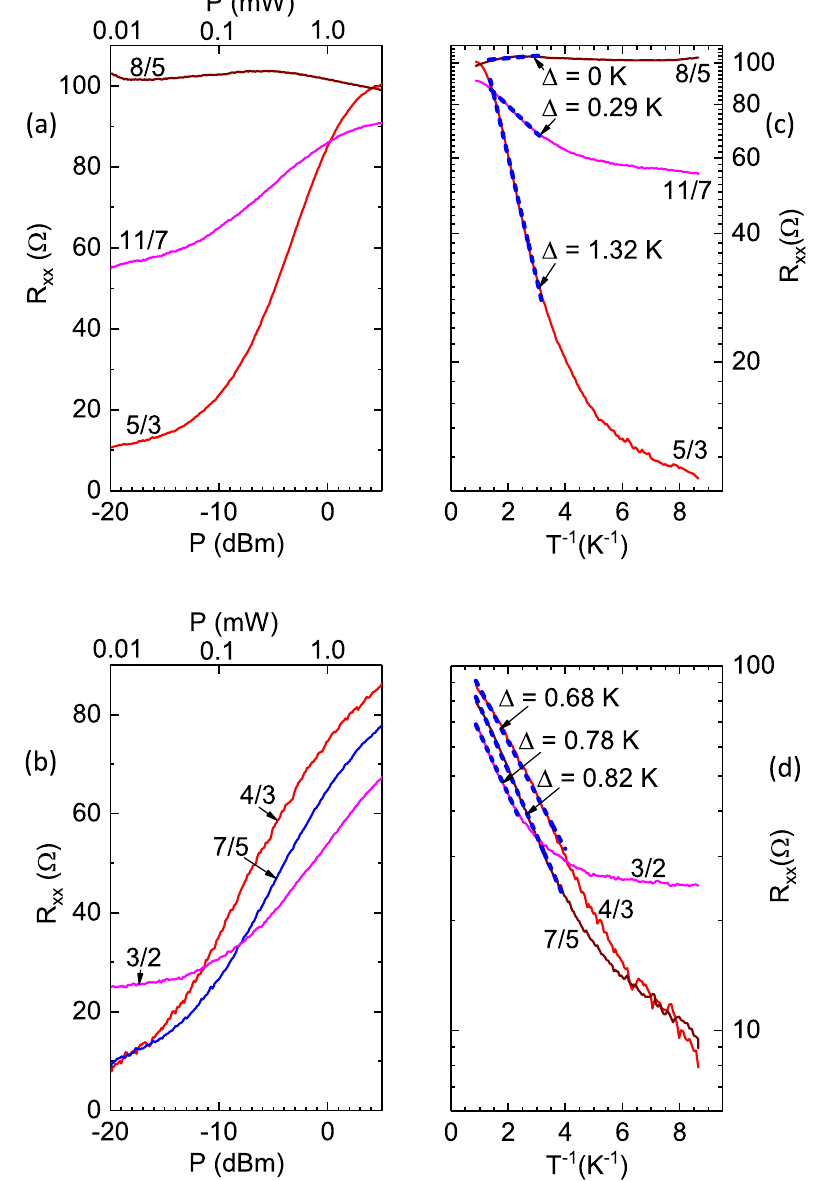
Figure 4. Extraction of activation energy at various filling factors of interest. ( a , b ) R xx vs P traces obtained with the specimen at base temperature. The panel ( a ) shows the results for filling factors 5/3, 8/5 and 11/7 , while the panel ( b ) shows the same for filling factors 4/3, 7/5, and 3/2. ((c),(d)) For these panels, the abscissa P of the left panels have been converted to the the inverse temperature T − 1 using the calibration exhibited in the Fig. 3c. These panels also exhibit an activation fit, which is indicated by the dashed blue line, for each trace. Note that the activation energy (cid:31) vanishes only for filling factor 8/5, indicating a gapless metallic state at 8/5. This feature is consistent with the absence of the FQHE resistance minimum at ν = 8 / 5 in Fig. 2. Note also the finite activation energy, �( 3 / 2 ) = 0.78 K , at ν = 3 / 2